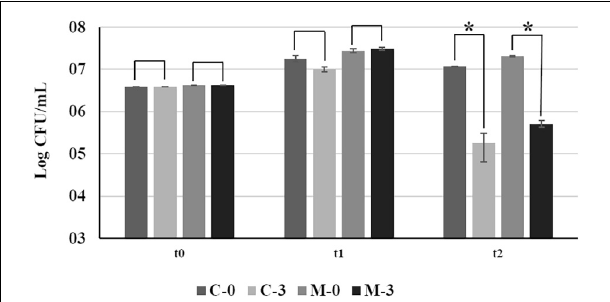
FIGURE 1 | Bacterial growth of Xf -EV and Xf-mqsR under normal conditions and after copper stress at different time points. C-0: Xf -EV; C-3: Xf -EV + 3 mM CuSO 4 ; M-0: Xf - mqsR ; M-3: Xf - mqsR + 3 mM CuSO 4 . t0: initial inoculum; t1: 14 days of growth; t2: 24 h after copper treatment, at the end of 15 days. Three independent experiments were performed with similar results. * indicates statistical significance by Student’s t -test ( p ≤ 0.05, n = 4).